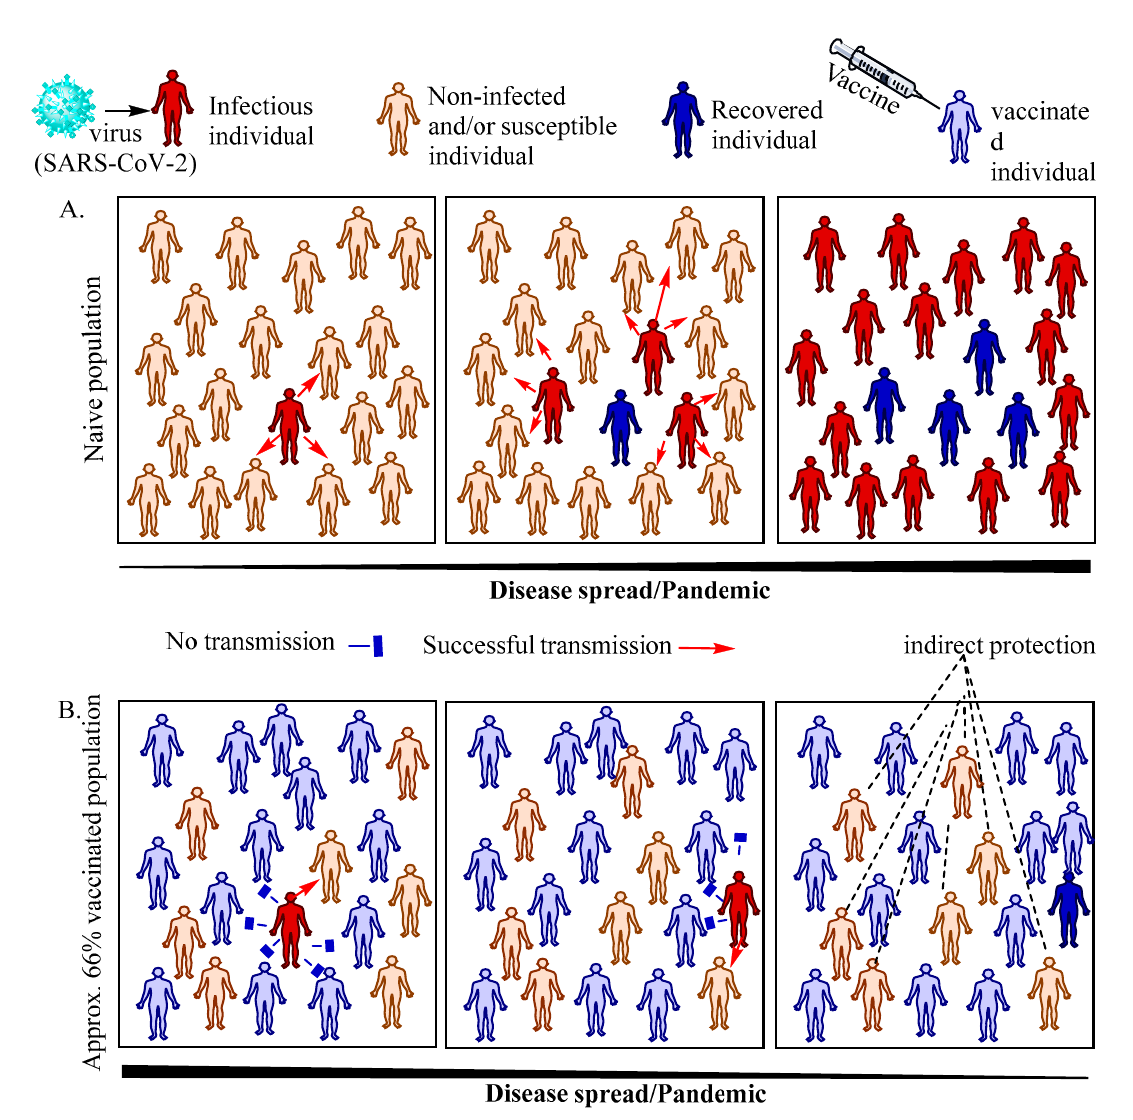
Figure 4. Schematic representation of dynamics of infectious diseases. Following introduction of one infected person in naïve population (hypothetical) consisting of majority of susceptible individuals ( A ) versus population consisting of 66% vaccinated individuals (66% is approximation and hypothetical value, which is actually decided considering the R0 that differs infectious disease-wise)/herd immunity ( B ). Following disease outbreak, the risk of contagion is very high, spreading rapidly through naïve population, whereas it is minimal in vaccinated population, protecting even susceptible individuals due to immune shield/barrier around them in the form of vaccinated individuals. Therefore, vaccination results into failure of virus spread and persistence in the population.